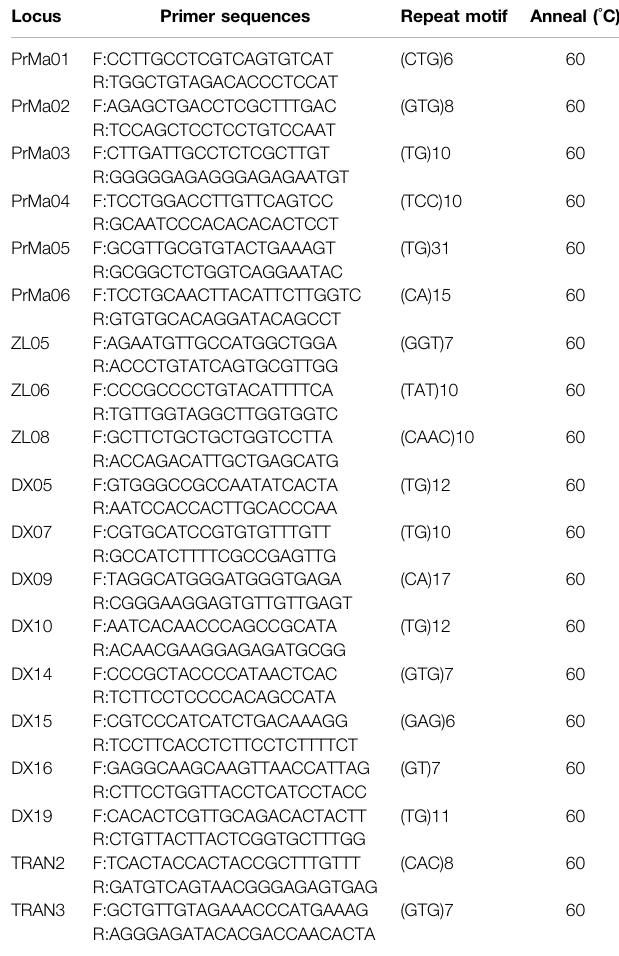
TABLE 1 | Characteristics of 19 SSR loci for P. trituberculatus